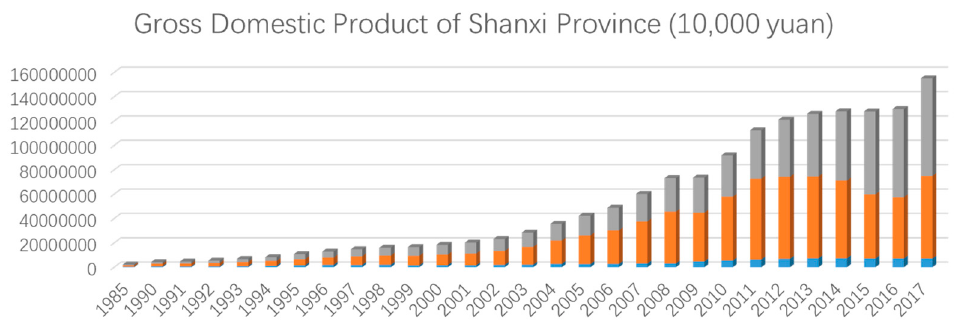
Figure 6. The Gross Domestic Product (GDP) of Shanxi province and Wutai county.